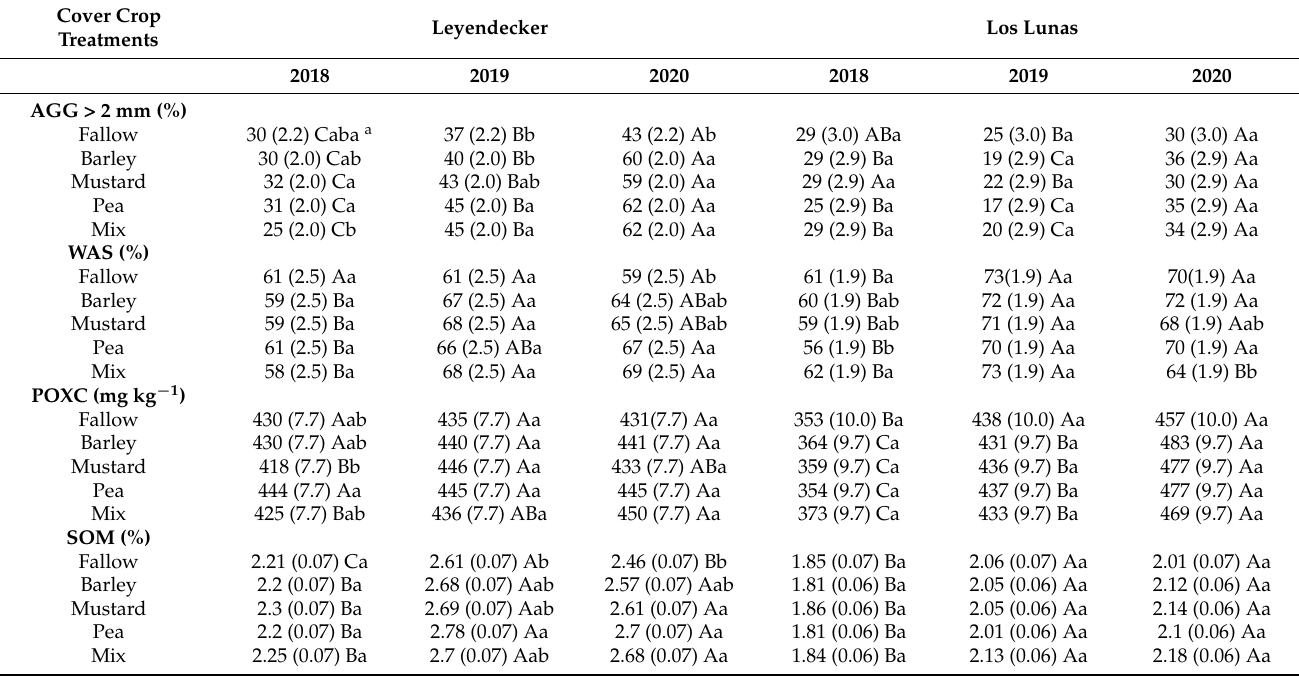
Table 1. Mean values ( ± SE) for large aggregates (AGG > 2 mm), wet aggregates stability (WAS), permanganate oxidizable carbon (POXC), and soil organic matter (SOM)at Leyendecker and Los Lunas sites. Means have been averaged over the irrigation treatments (n = 12 per treatment).